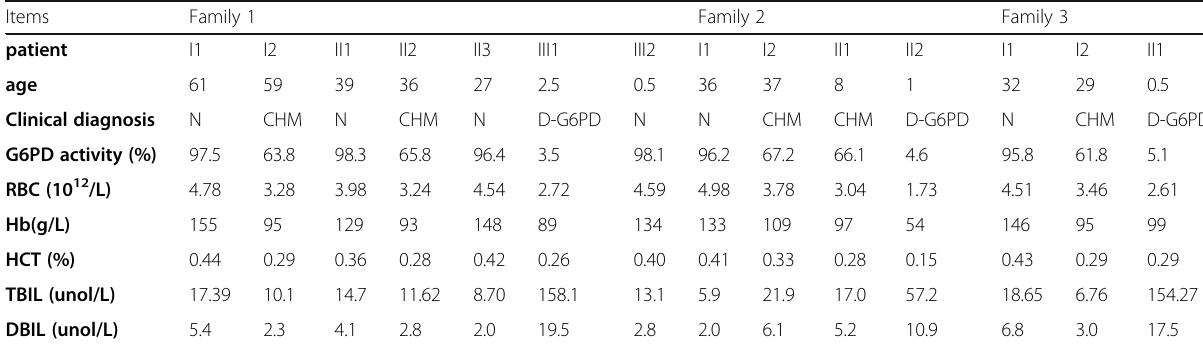
Table 2 The clinical data of three families Items